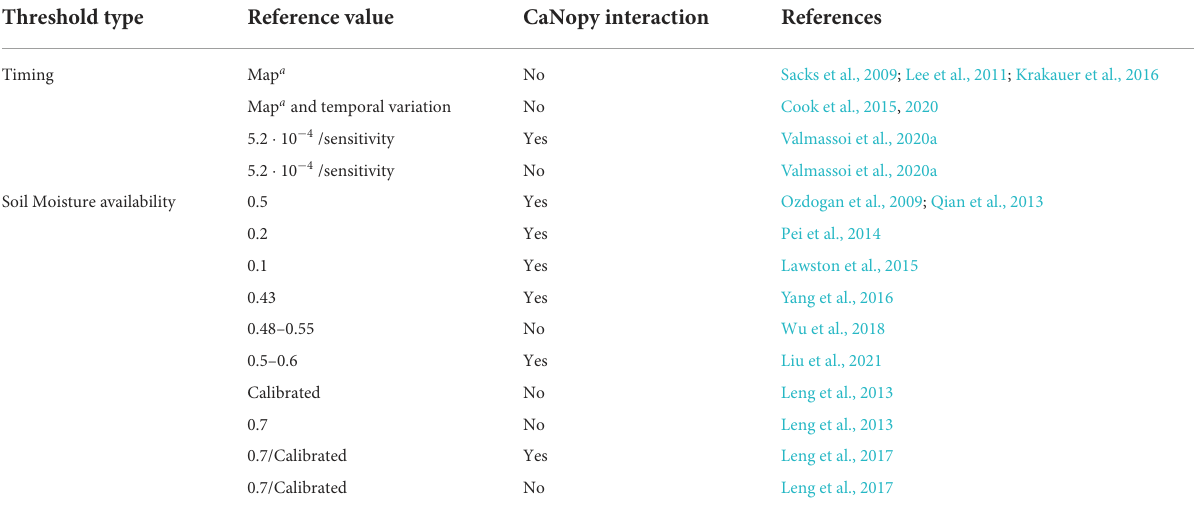
TABLE 4 Summary of the irrigation parameterizations as water applied to the surface with the different parameters used in the available